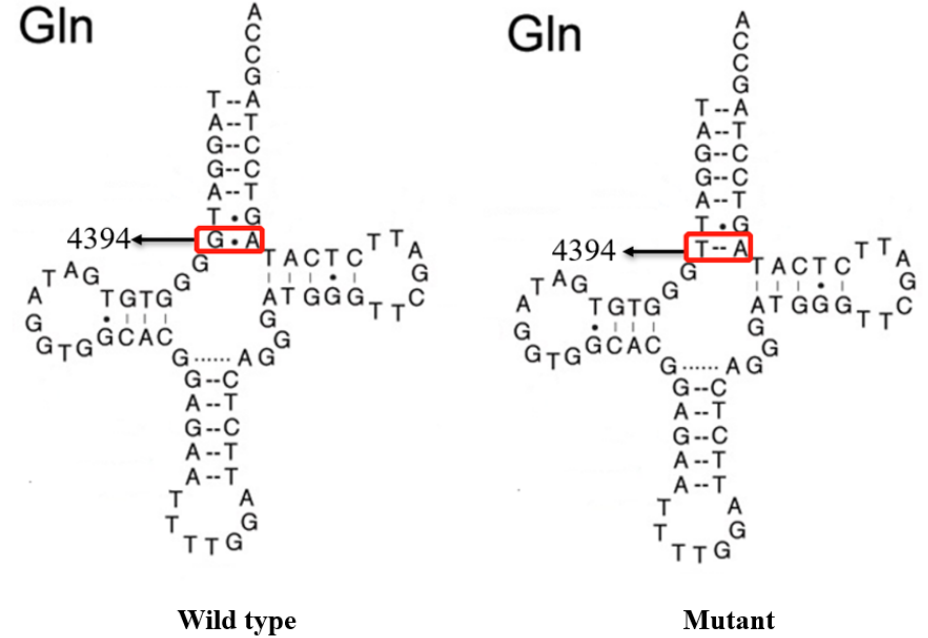
Figure 4. Secondary structure of mt-tRNA Gln with and without the m.4394C>T mutation, which is derived from Mitomap database (www.mitomap.org). Arrows denoted the position of the m.4394C>T mutation.